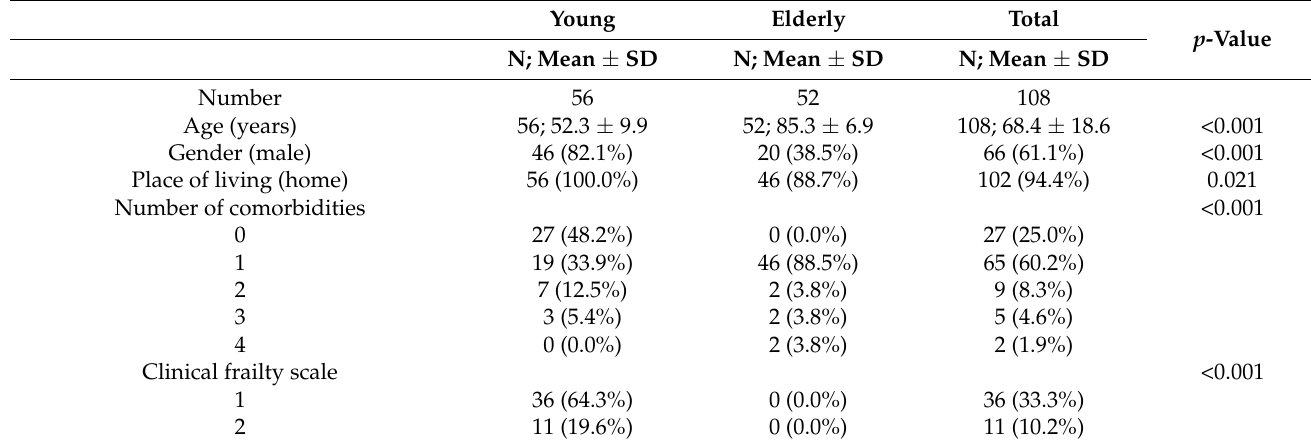
Table 1. Clinical and biological characteristics of study